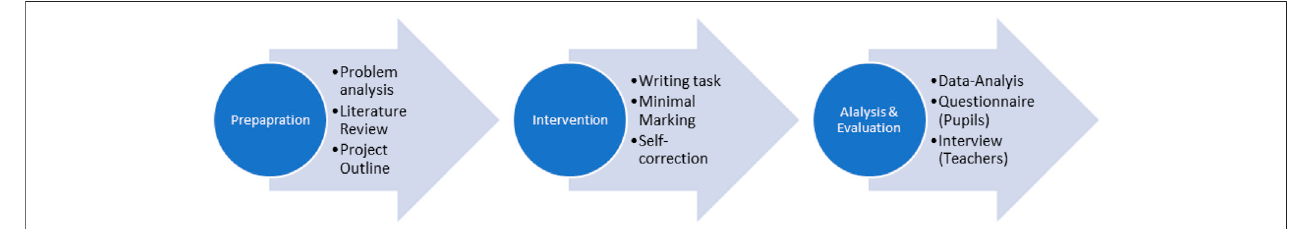
FIGURE 2 | Experimental setup of case